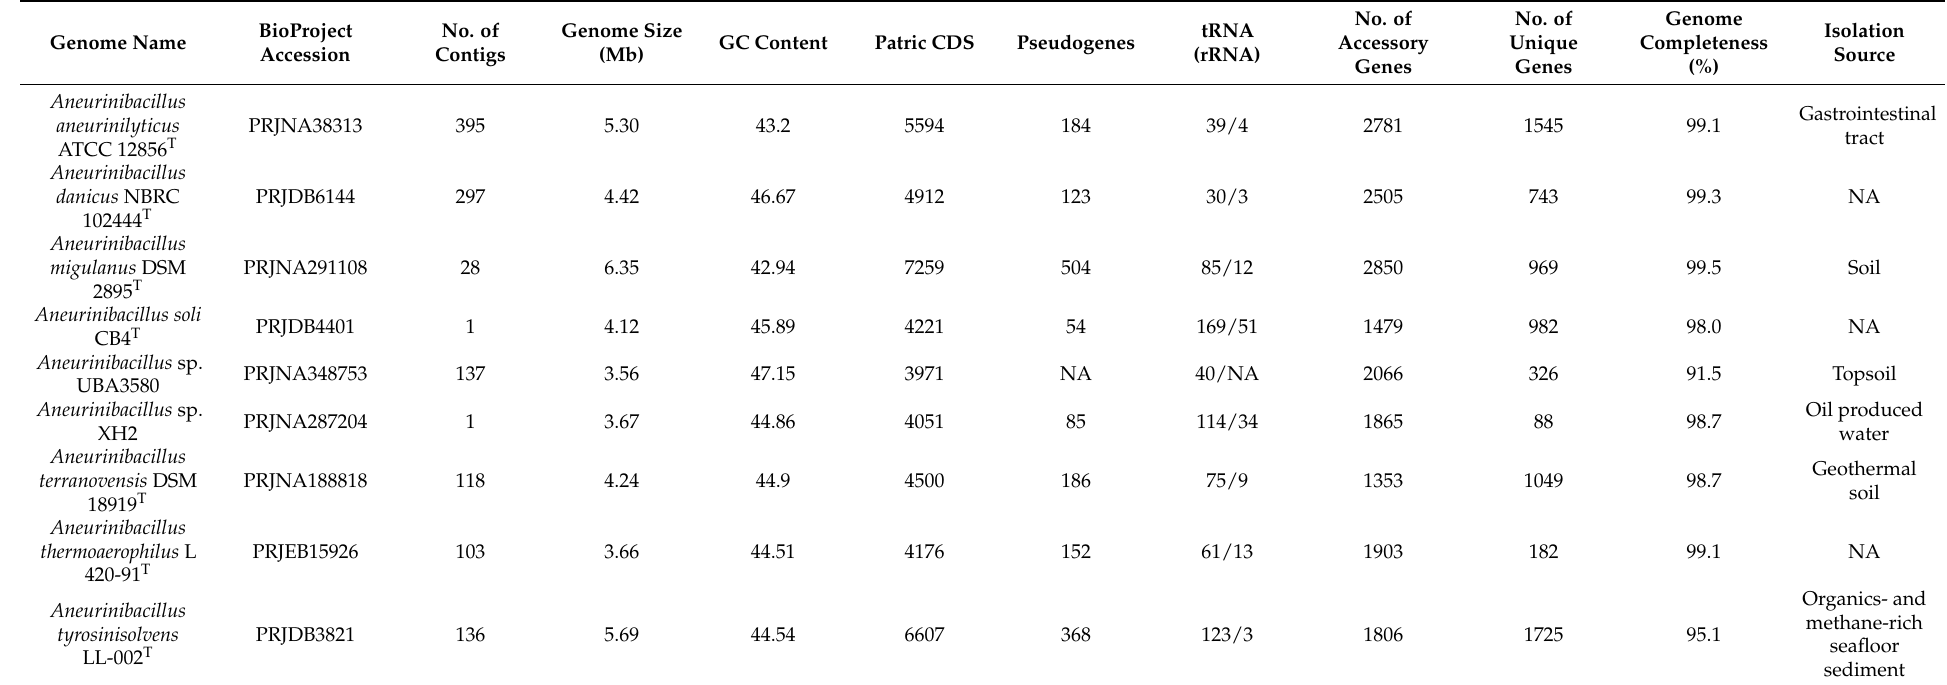
Table 1. Overview of the general genomic features of nine Aneurinibacillus strains analyzed in this